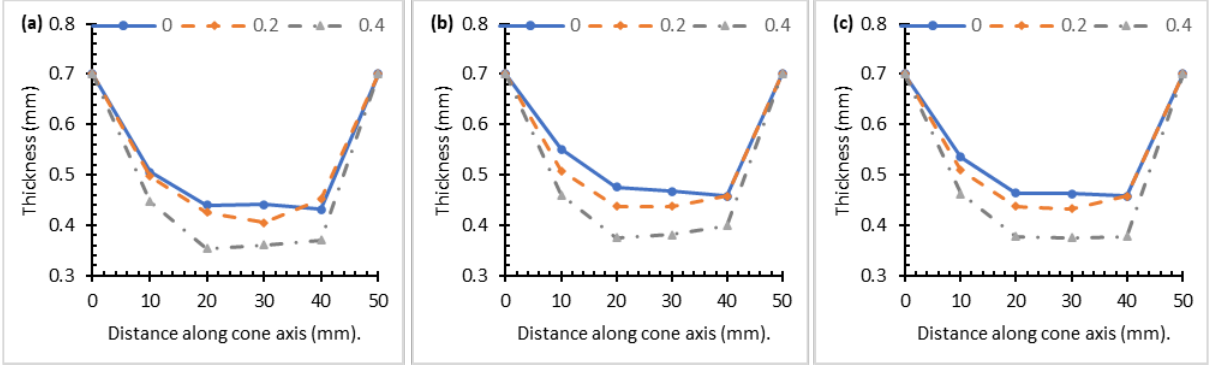
Figure 15. Thickness spatial variation at end of process as predicted by simulation using ( a ) GTN material model, ( b ) FFLD model, and ( c ) DD material model for different pressure settings. Table 3. Comparison of experimental and numerical results of various material models at different pressure settings.